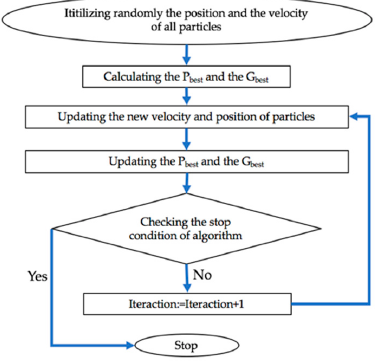
Figure 4. The general schema of both PSO algorithms.